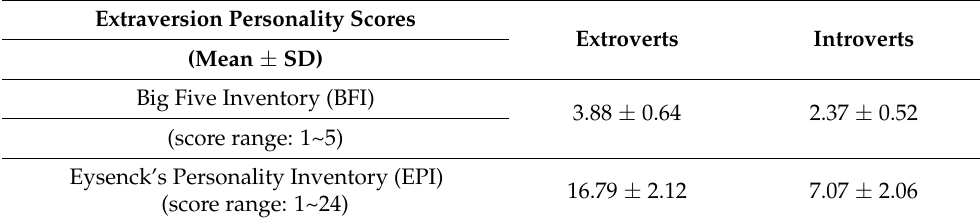
Table 1. Extraversion personality scores between extroverts and